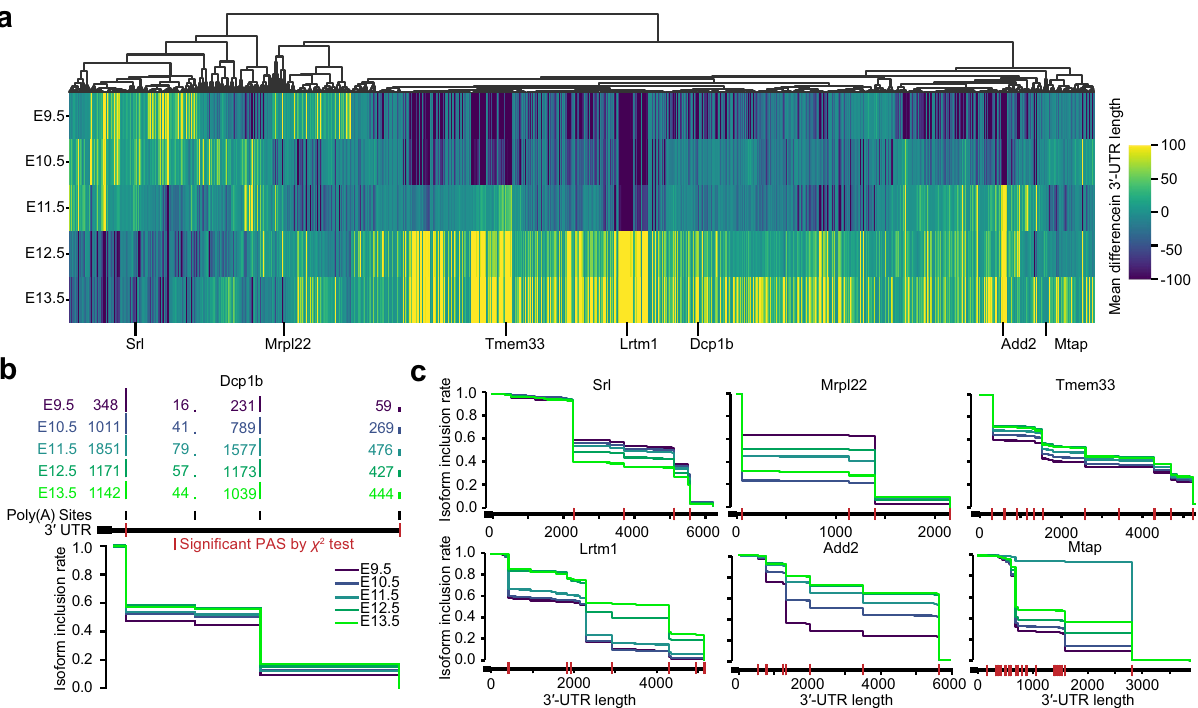
Fig. 4 Identi fi cation of distinct gene lengthening patterns and genes responsible for overall data trends across embryonic ages. a Heatmap of mean differences in 3 ′ -UTR lengths for 5169 genes with signi fi cant differences in PAS usage across embryonic stages. Heatmap is column-centered and clustered by Pearson correlation as a distance metric. b Schematic of IIR plot visualization using PAS counts for each of fi ve embryonic stages. Vertical red lines along the 3 ′ -UTR indicate PASs that are signi fi cantly different between stages by the χ 2 test ( P < 0.05). c IIR plots for six genes among representative clusters shown in ( a ), and colored by embryonic stage. See also Supplementary Fig. 5 for clustering according to differences in entropy. See also Supplementary Data 3 for a table of read counts associated with each PAS for each gene and embryonic